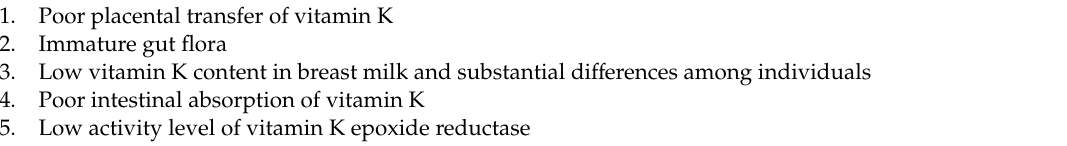
Table 3. Possible factors inducing vitamin K deficiency in